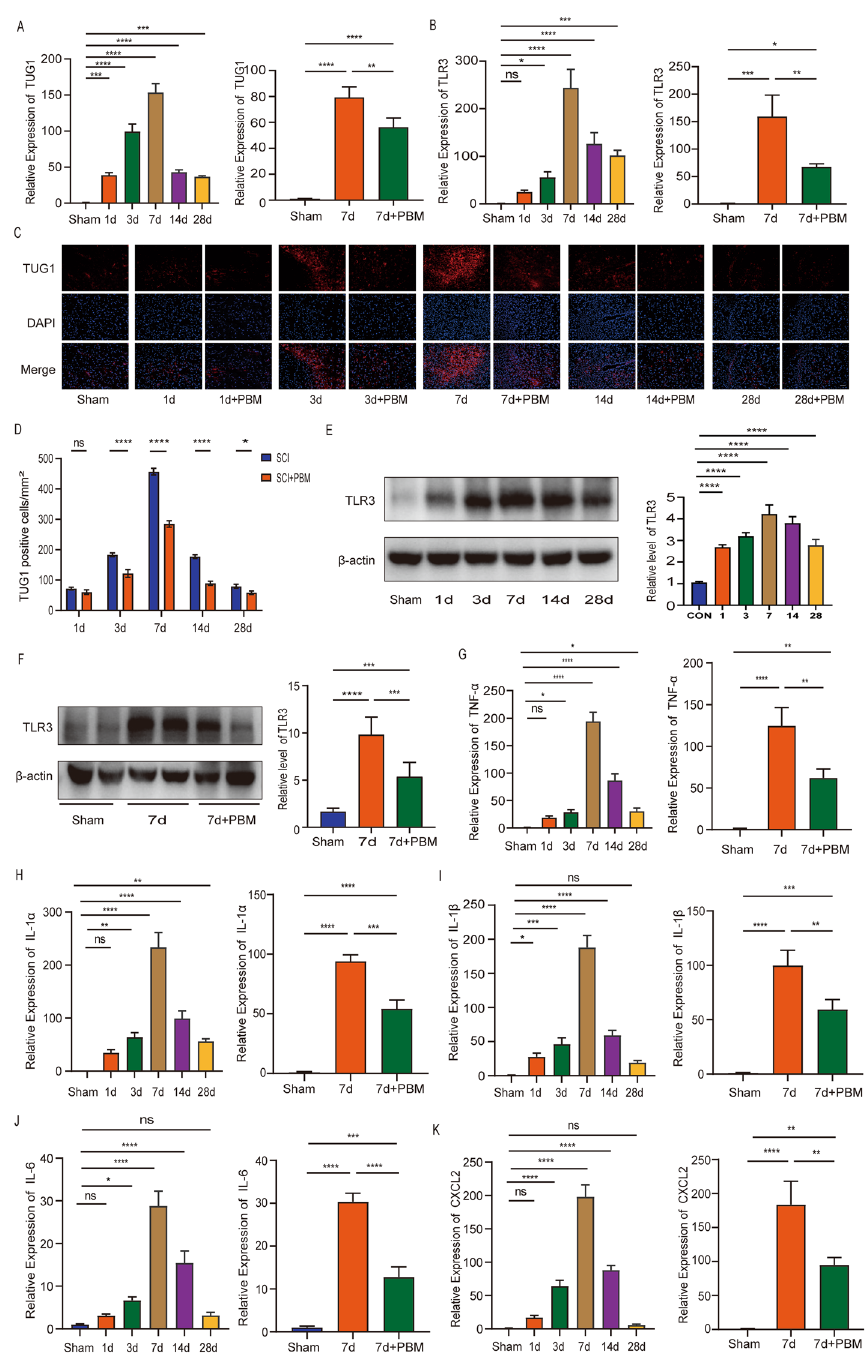
Fig. 7 PBM can inhibit the expression of TUG1, TLR3, and inflammatory cytokines in SCI mice. A , B RT-PCR was used to detect the expression of TUG1 and TLR3 at 1, 3, 7, 14, and 28 days after SCI. In addition, RT-PCR results showed that the expression of TUG1 and TLR3 decreased after 7 days of PBM treatment. C , D FISH assay was used to detect the expression of TUG1 in SCI group and PBM group at 1, 3, 7, 14, and 28 days after SCI. Scale bar, 200 μm. E The protein expression level of TLR3 was detected by western blotting at 1, 3, 7, 14, and 28 days after SCI. F PBM treatment reduces TLR3 expression. ( G – K ) RT-PCR was used to detect the expression of TNF-α, IL-1α, IL-1β, IL-6, and CXCL2 at 1, 3, 7, 14, and 28 days after SCI, and the expression of TNF-α, IL-1α, IL-1β, IL-6, and CXCL was reduced after 7 days of PBM treatment. n 3 per group. * P < 0.05, = *** P < 0.001, *** P < 0.001, **** P < 0.0001. ns not